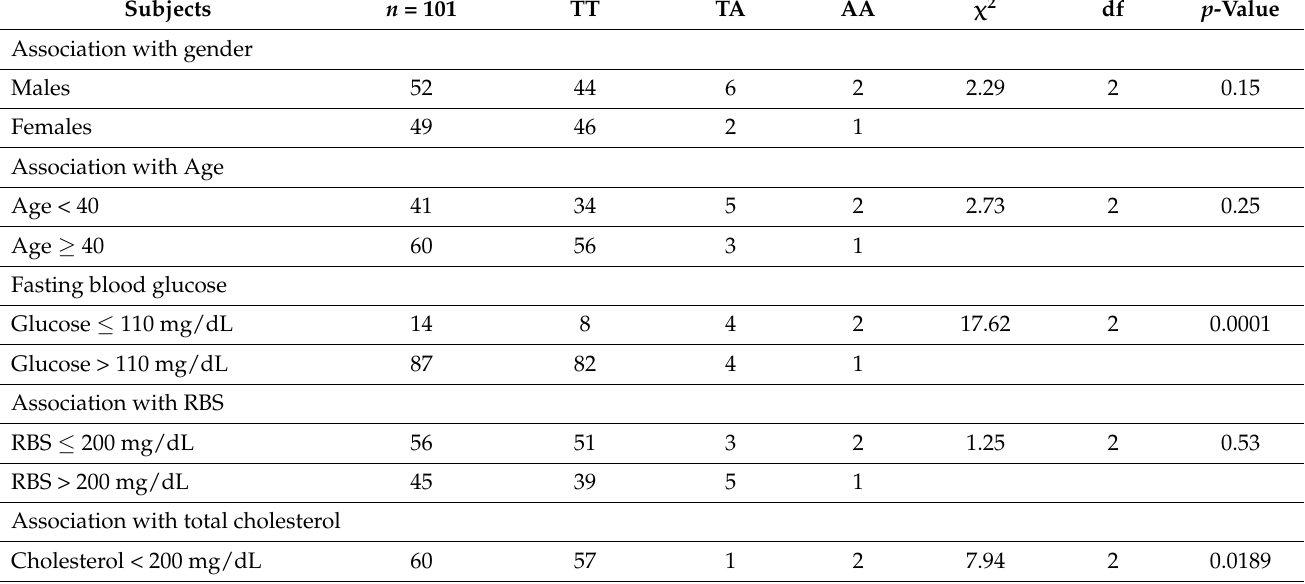
Table 9. Association of GLO-rs1130534 T>A SNP genotype with patient